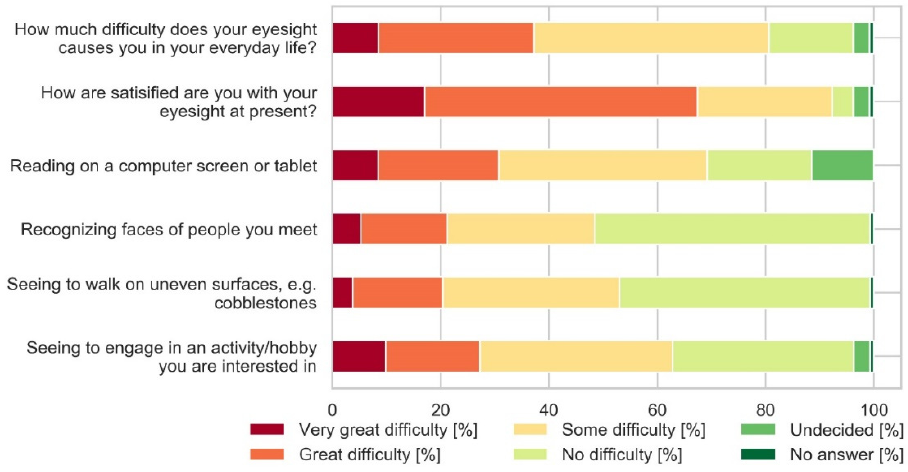
Figure 7. Pre-operative Cat-Quest 9 task Figure 7. Pre ‐ operative Cat ‐ Quest 9 task results. Figure 7. Pre ‐ operative Cat ‐ Quest 9 task results.